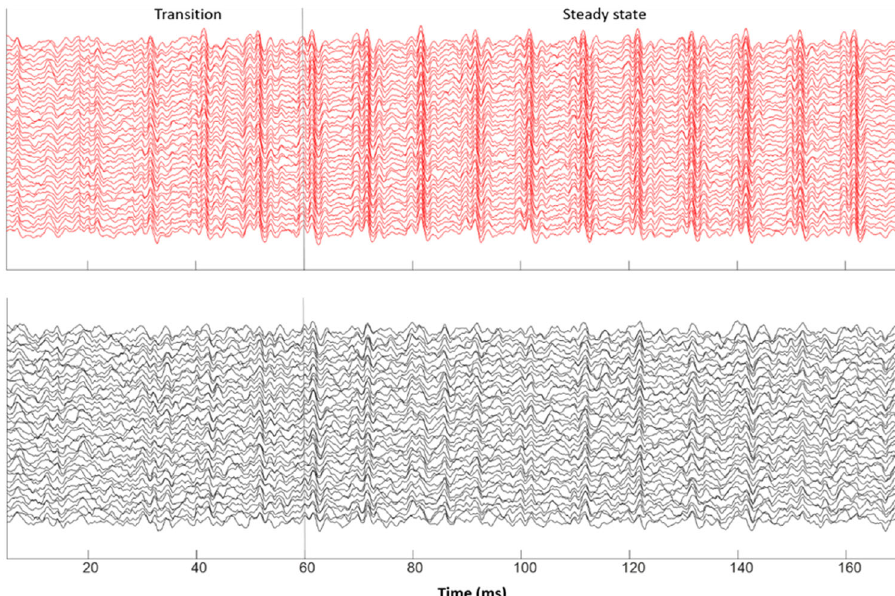
Fig. 4 Visual representation of the difference in neural stability seen between FFRs from a representative Synchronizer (red) versus a representative Non-synchronizer (black). In each panel, forty samples of 2000-sweep subaverages are overlaid, giving a visual indicator of what it means to have high or low neural stability of the FFR. The responses shown were elicited from a [ba] stimulus, presented in a quiet condition.